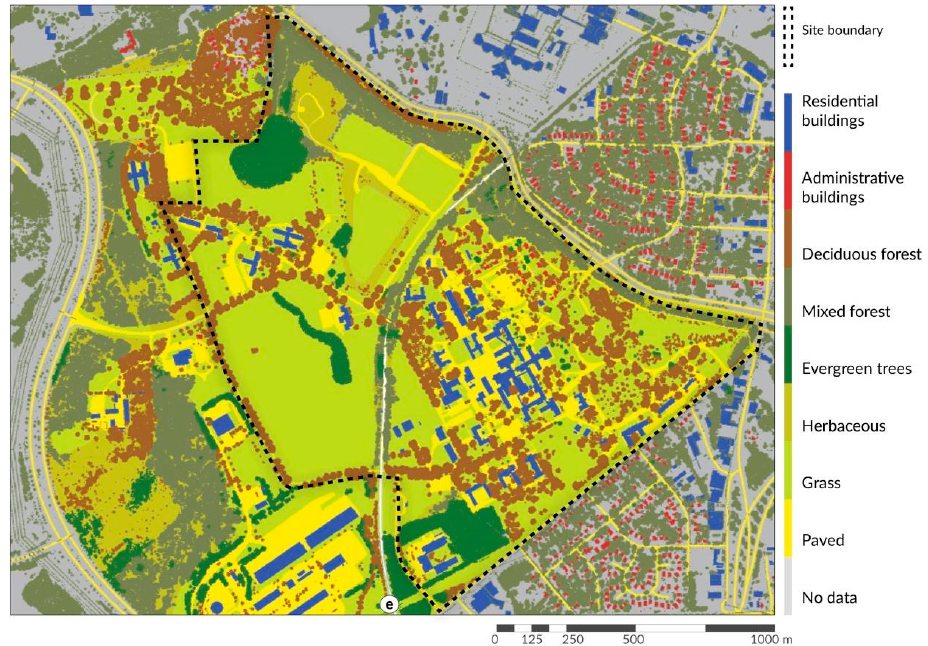
Figure 8. Developed detailed landcover map for the study area.